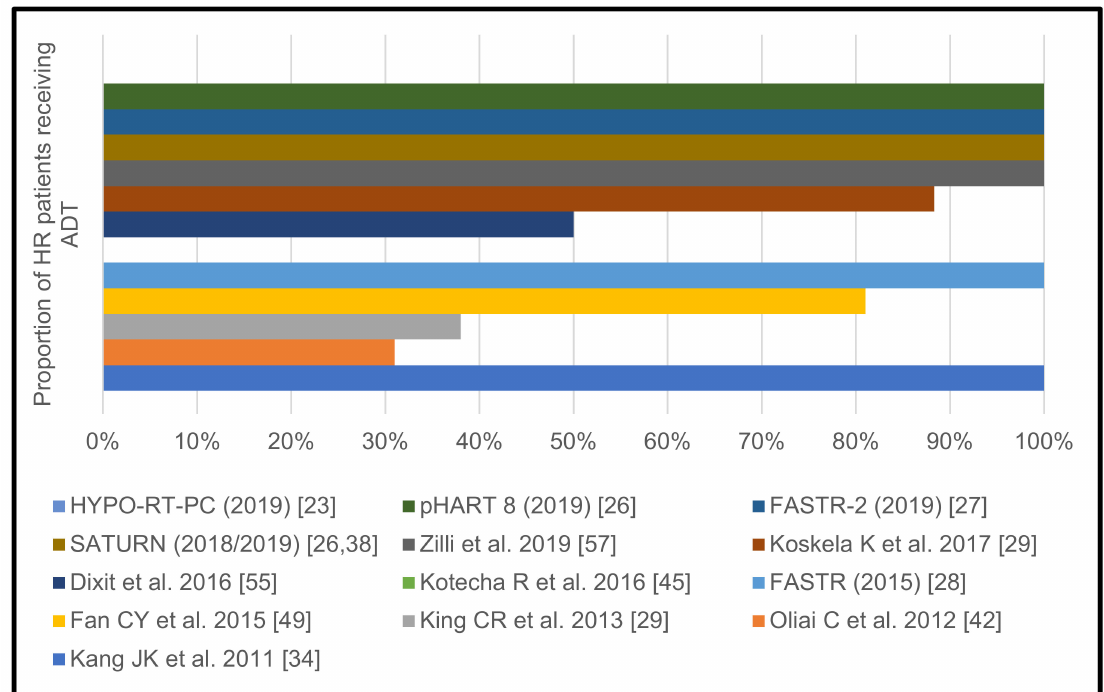
Figure 6. Proportion of high-risk prostate cancer patients receiving androgen deprivation therapy per individual